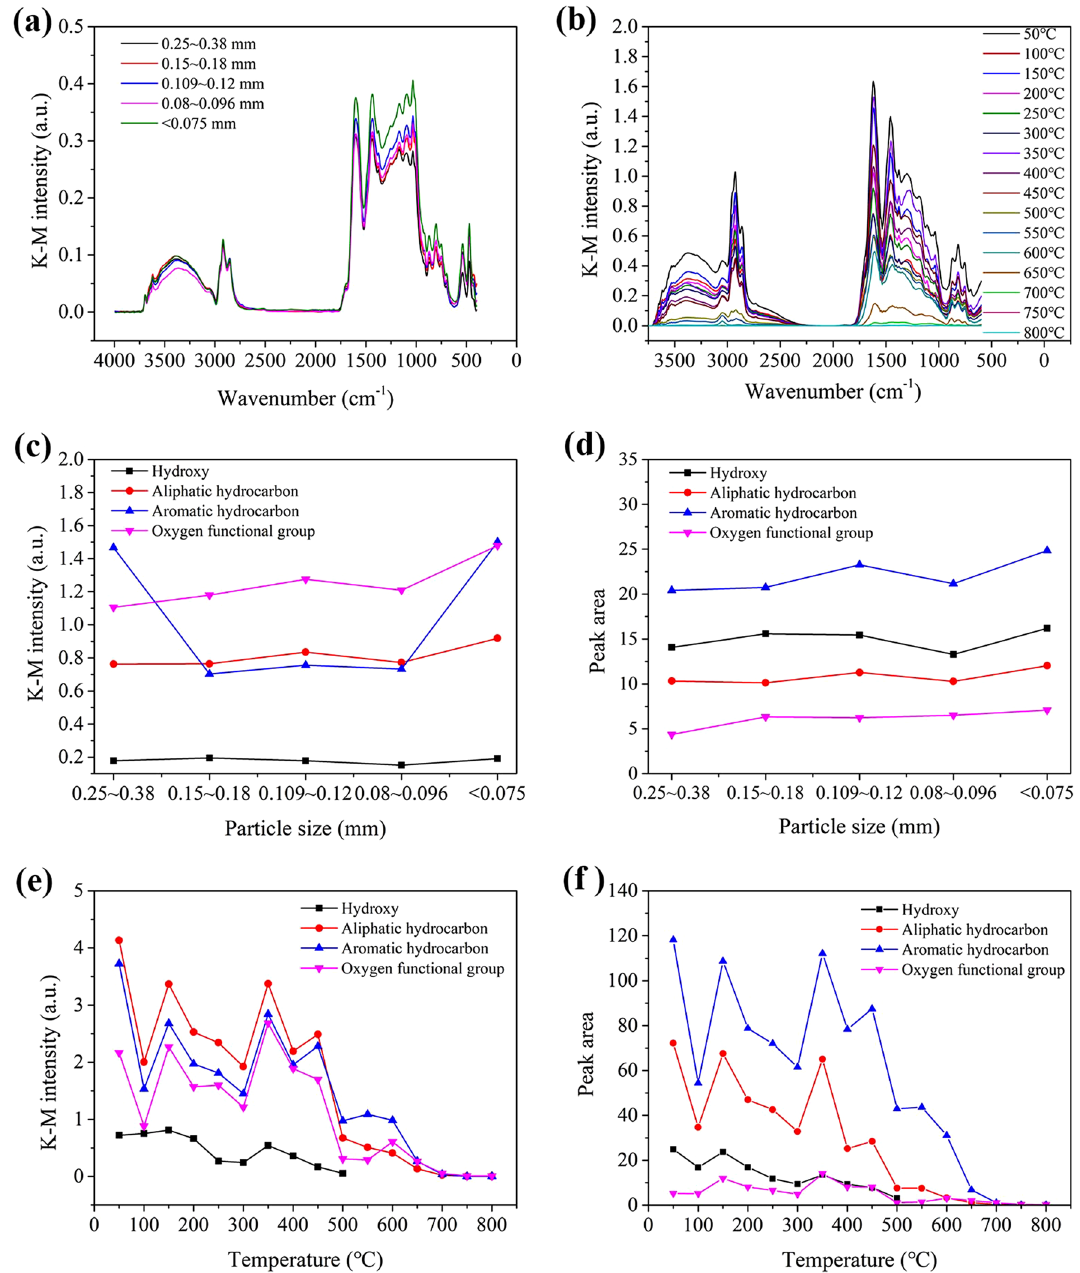
Figure 6. Results from FTIR experiments: ( a the infrared spectra with different particle sizes; b the infrared spectra with heated samples; c , d the absorbance and peak areas of the functional groups with different particle sizes respectively; e , f the absorbance and peak areas of functional groups of heated samples